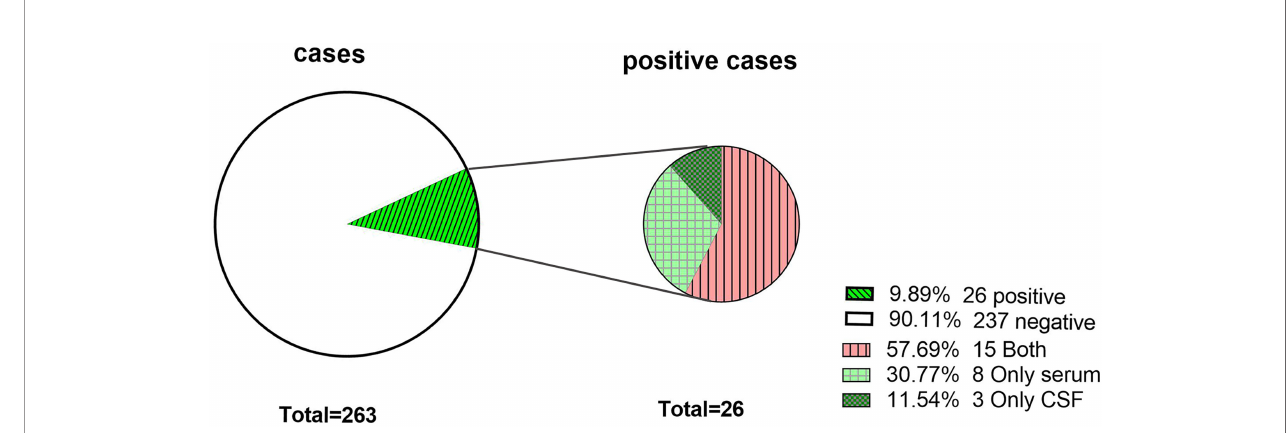
FIGURE 2 | The antibody-positive rate of the study population. Antibodies were detected in both CSF and serum. Only serum, antibodies were detected in only serum. Only CSF, antibodies were detected in only CSF.